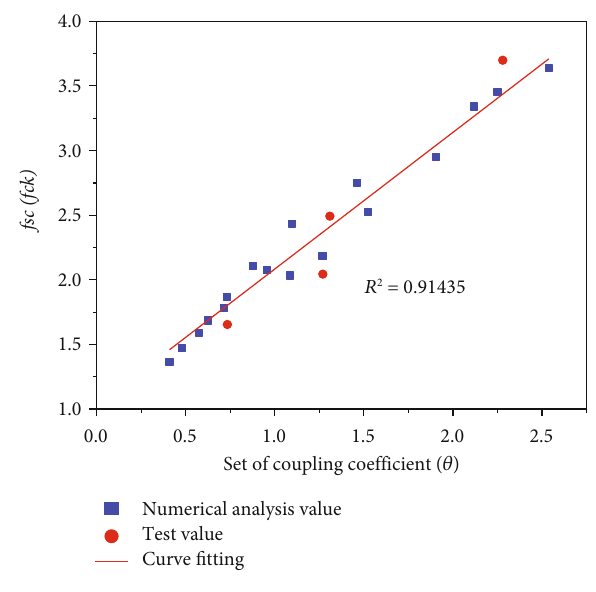
Figure 12: Relation between f